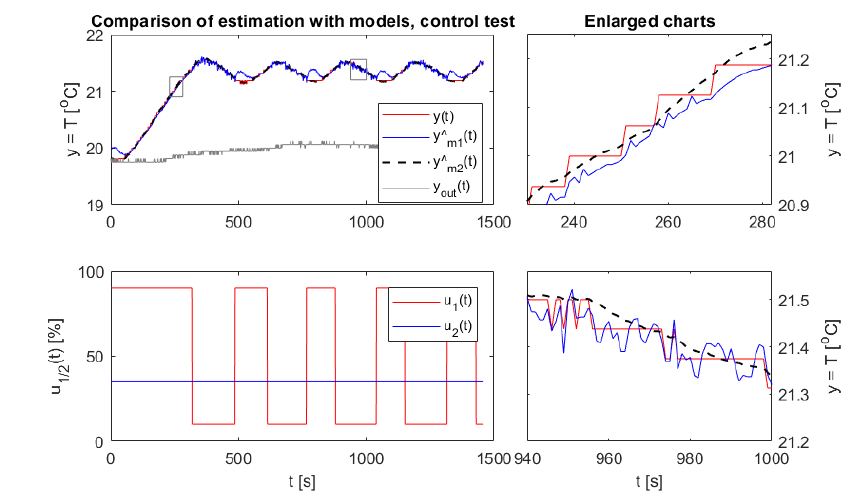
Figure 10. Experimental results for 1000 particles; the measured value (red), estimated values from assumed models (blue and black), and outdoor measurement (gray); and the input